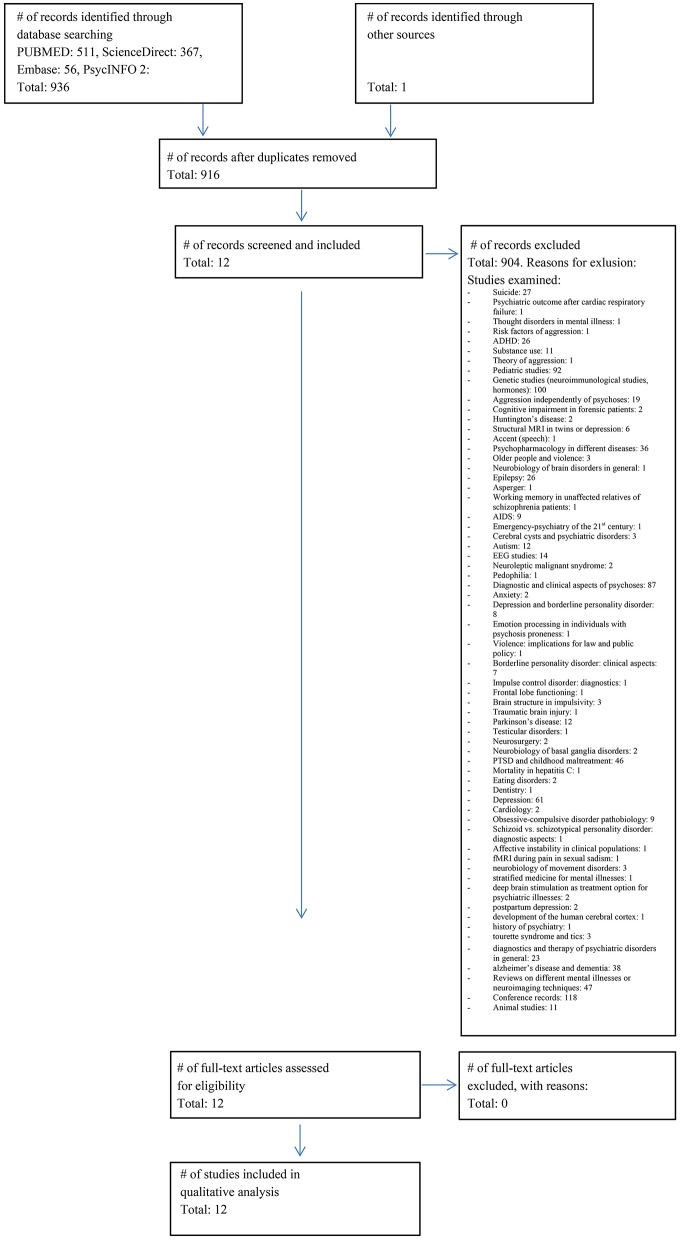
Prisma flow chart. Flowchart of the literature search (03.09.2017) and included studies according to the PRISMA guidelines (20).